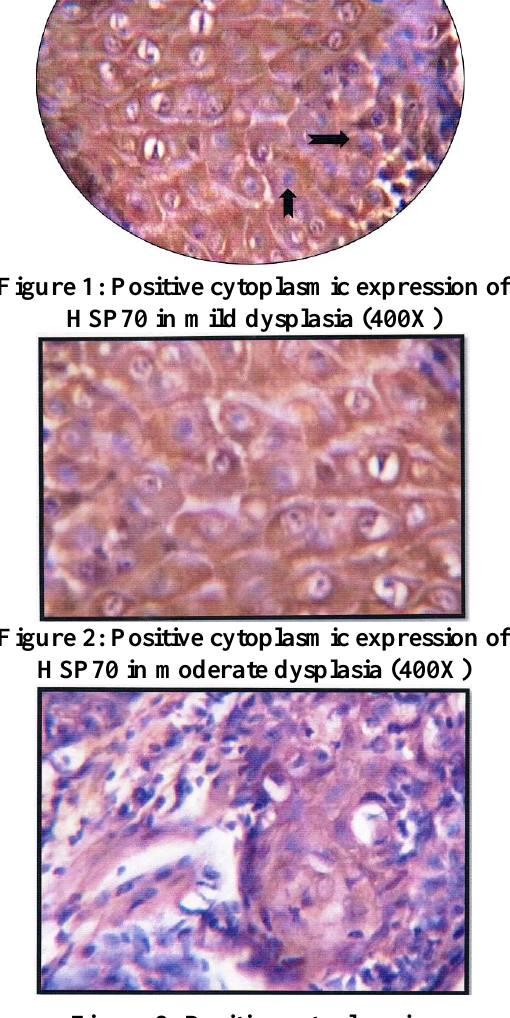
Figure 3: Positive cytoplasmic expression of HSP70 in well differentiated SCC